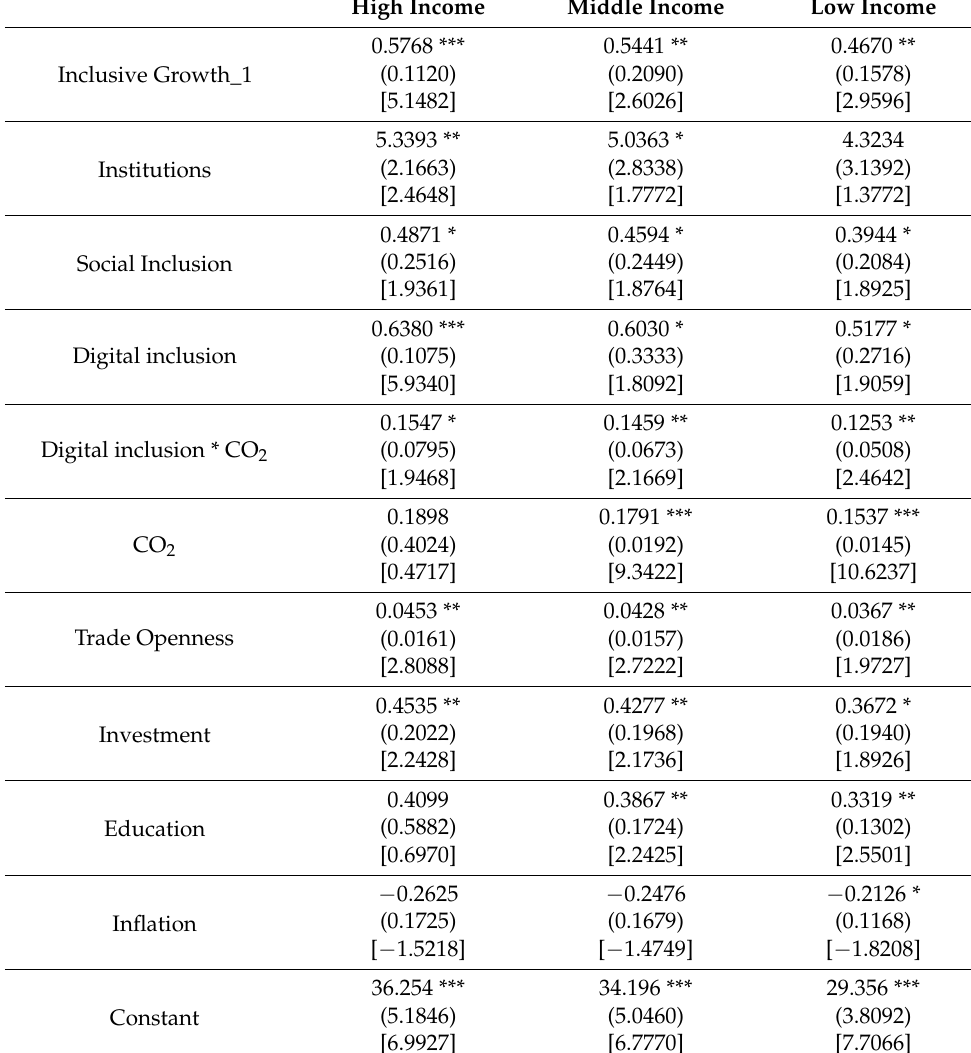
Table 3. Results for the impact of CO 2 on inclusive growth with digital inclusion * CO 2 . High Income Middle